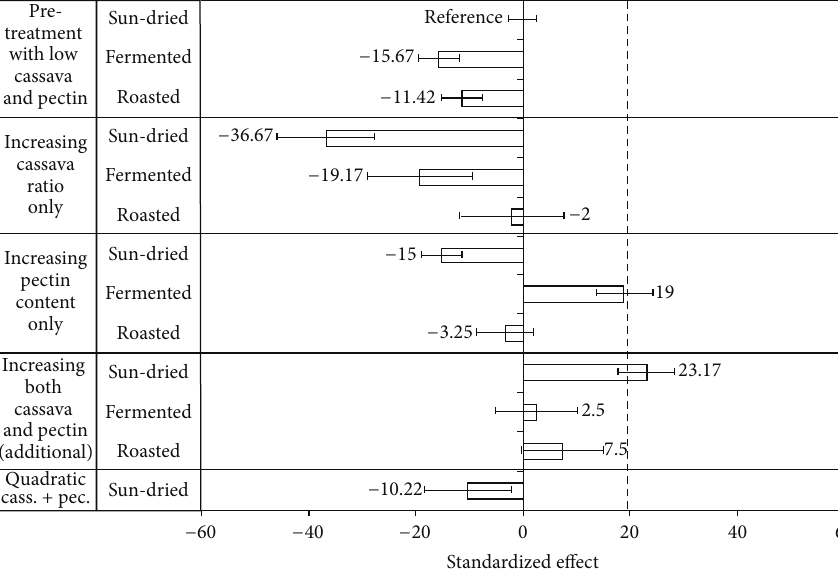
Figure 1: Modified Pareto chart showing the relative effects of pretreatments, flour composition factors, and the interaction of these on bread volume according to the regression model ( 𝑅 2 = 0.75 ). Bread made with sun-dried flour with low cassava and low HM-pectin contents was set as reference bread. The volume of wheat bread is indicated by a dotted line. Effects with error bars not including point 0 are statistically significant at 95% confidence level.